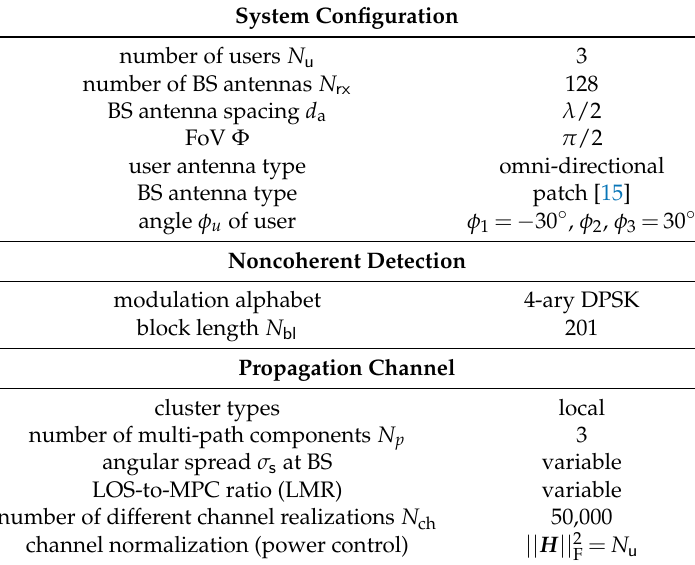
Table 1. System configuration and parameterization of propagation channel and noncoherent